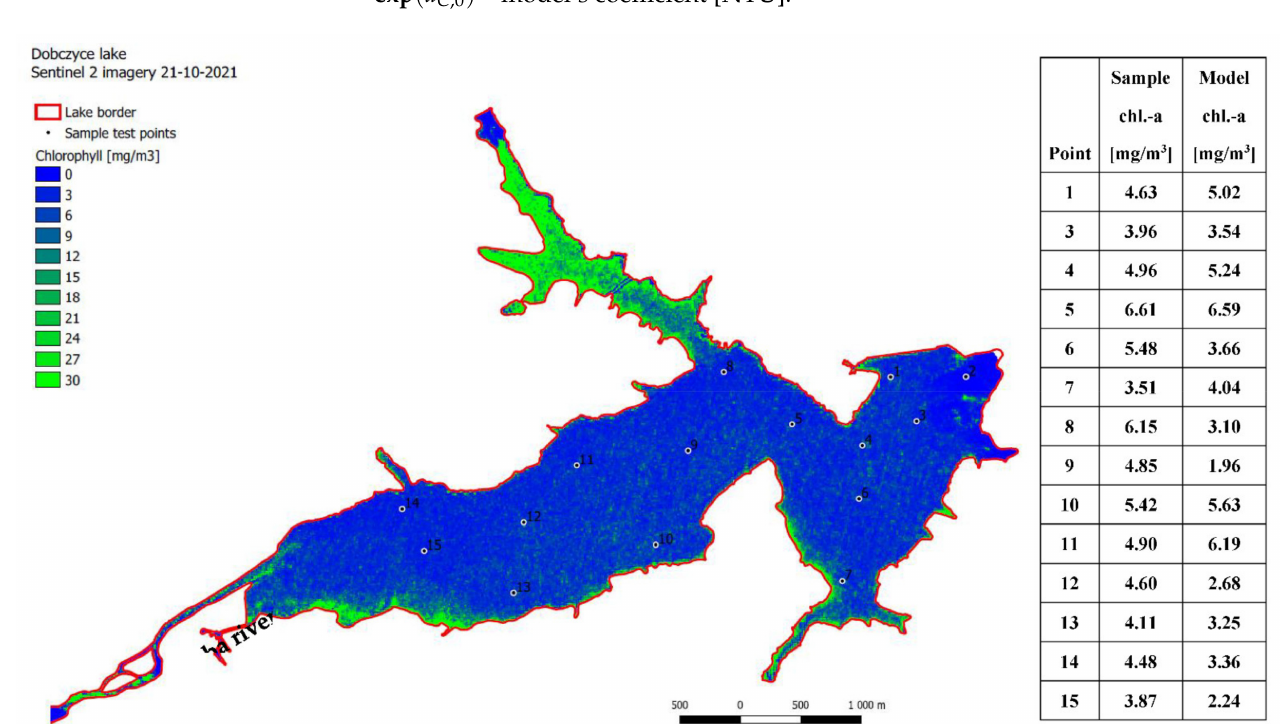
Figure 18. Chlorophyll concentrations in Lake Dobczyce, 21 October 2021 (imagery by Sentinel